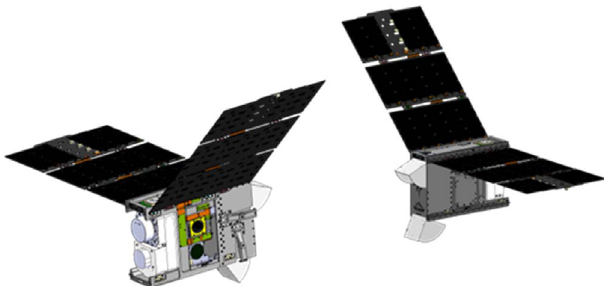
Fig. 1. Computer aided design (CAD) models illustrating the CIRCE concept (courtesy Blue Canyon Technologies).